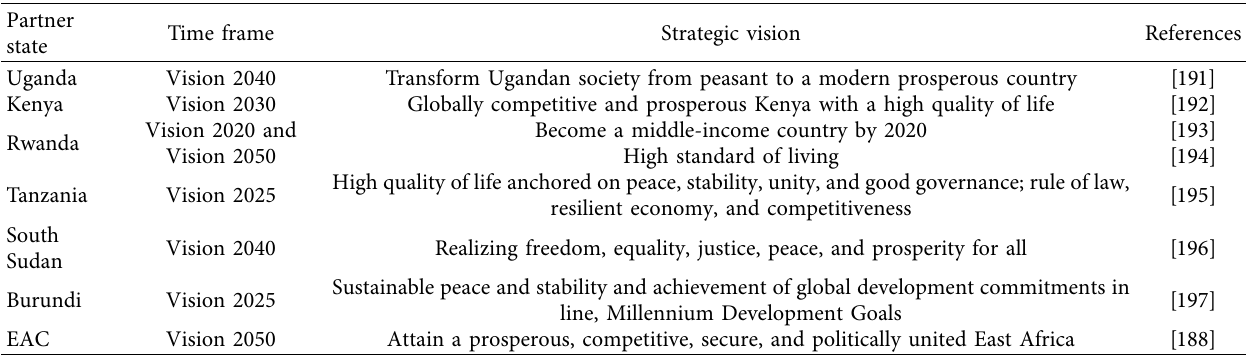
Table 10: Strategic vision of the EAC’s partner